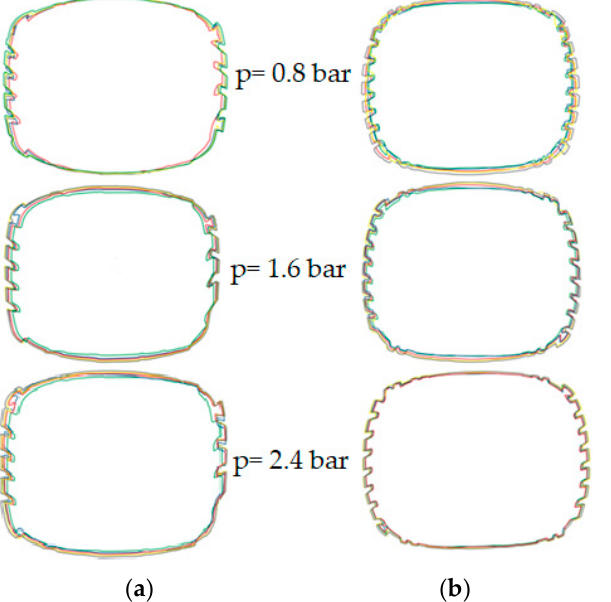
Figure 6. Visualization of horizontal cross-sections according to inflation pressure and vertical load: